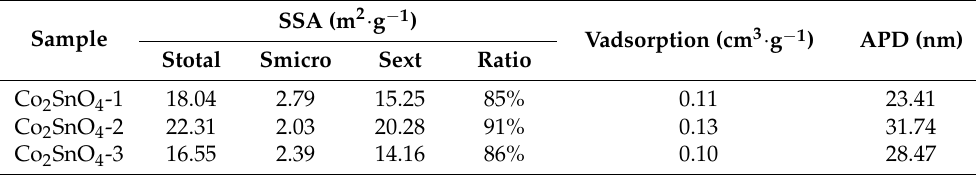
Figure 3. ( a ) Nitrogen adsorption/desorption isotherm, ( b ) pore size distribution plot, and ( c ) macropore size distributions of Co 2 SnO 4 -1, Co 2 SnO 4 -2, and Co 2 SnO 4 -3, respectively. Table 1. The surface area and pore size distribution of Co 2 SnO 4 -1, Co 2 SnO 4 -2, and Co 2 SnO 4 -3, re- spectively.